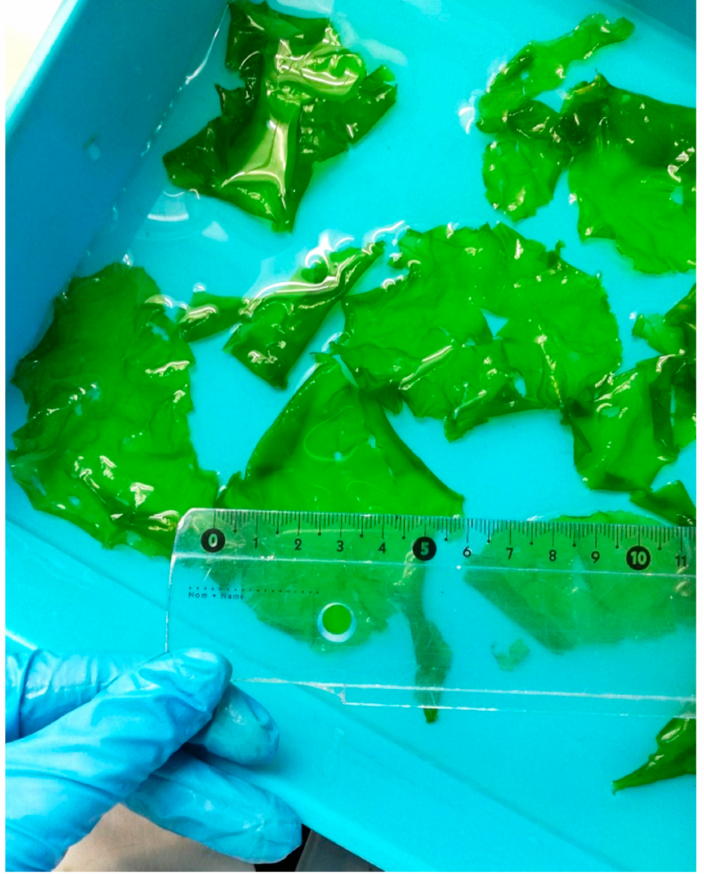
Figure 3. Ulva sp. specimens cultivated under controlled conditions at the MAREFOZ